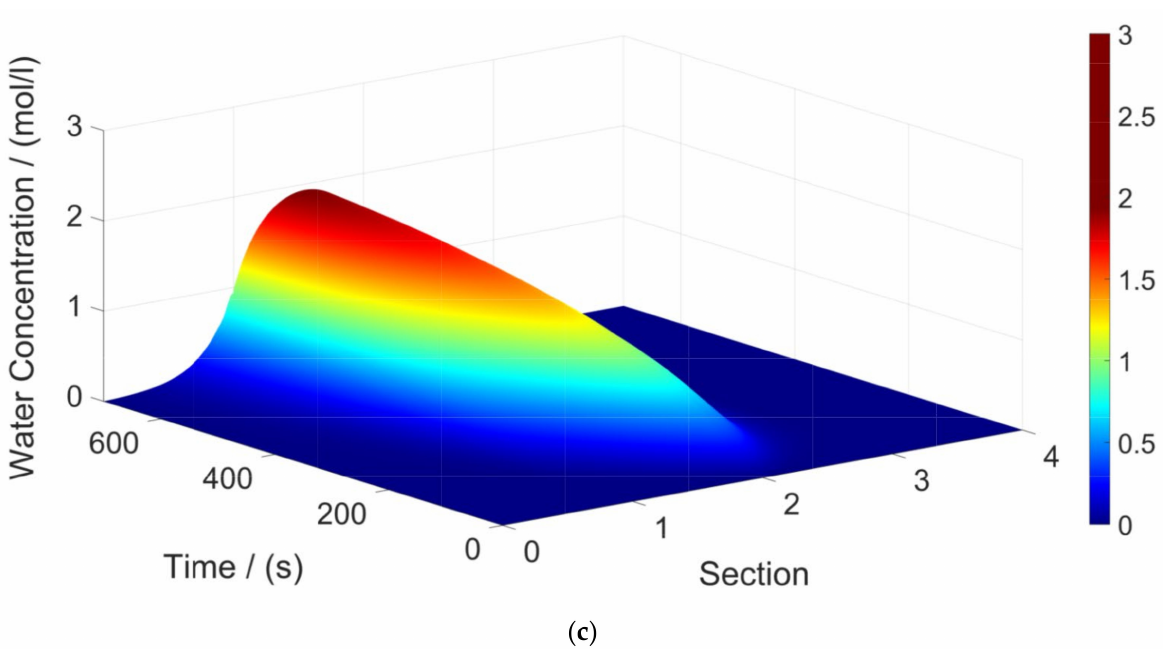
Figure 3. TMBR concentration profile along sections and time for ( a ) propanoic acid, ( b ) n-propyl propionate, and ( c ) water in a transient evolution.